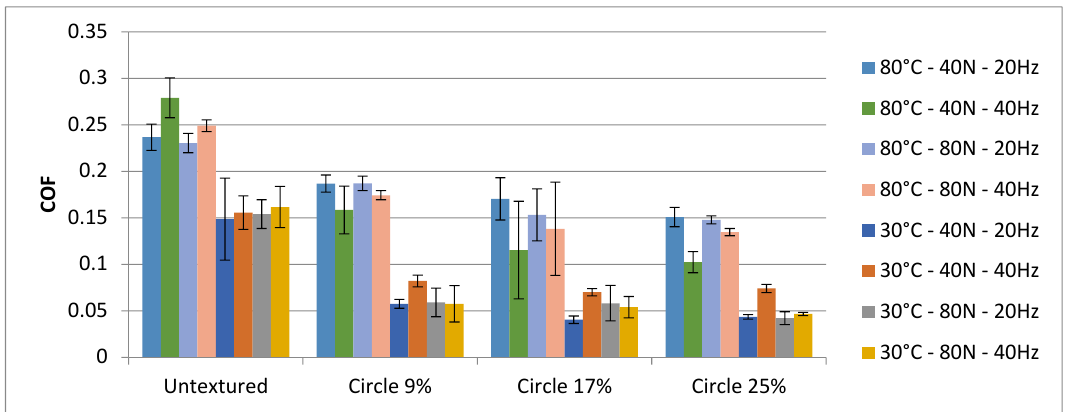
Figure 9. The mean values and error bars of the coefficient of friction of textured and untextured sliding pairs under various operating conditions .